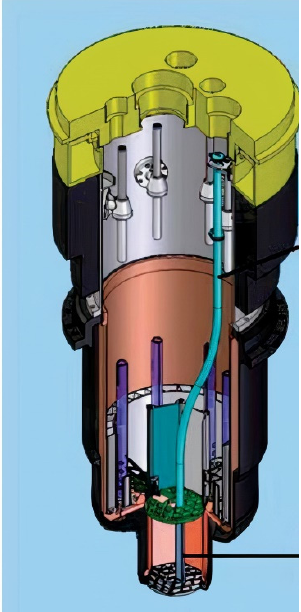
Figure 3. MITR pressure vessel [14].